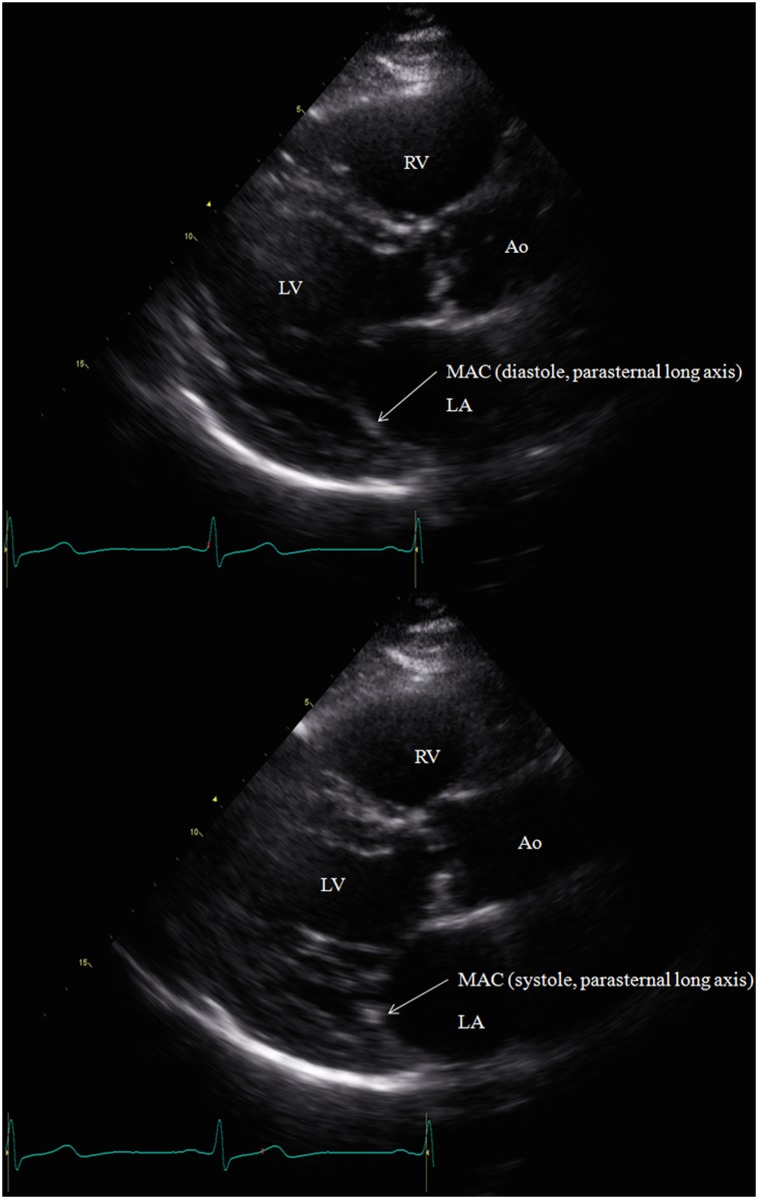
(A-B). MAC was defined as an echodense area visualized throughout systole and diastole, distinguishable from the posterior mitral valve leaflet, located anterior and parallel to the posterior left ventricular wall, seen here in the parasternal long axis view during diastole (A) and systole (B).Abbreviations: Right Ventricle (RV), Left Ventricle (LV), Aorta (Ao), Mitral Annular Calcification (MAC), Left Atrium (LA).